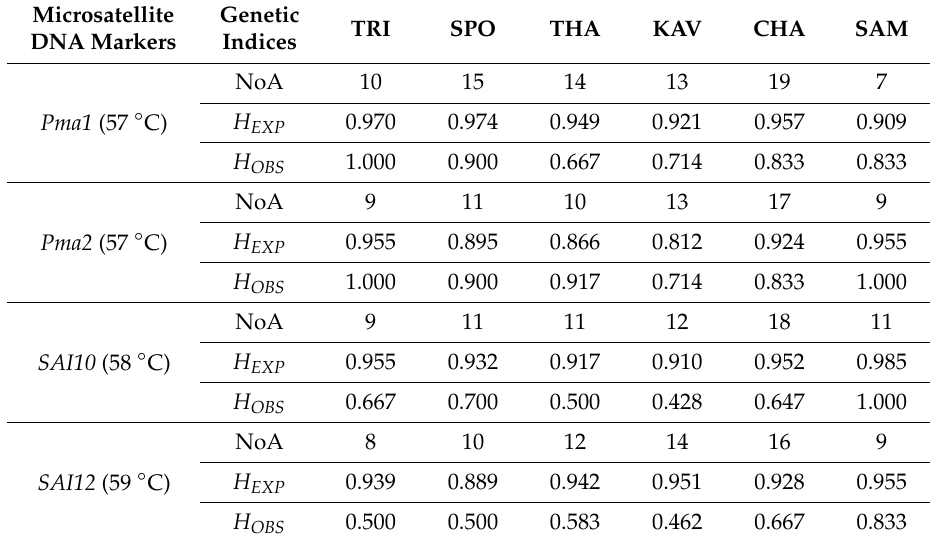
Figure 2. Cross-entropy plot for the number of cluster K = 1–8. The retained value of K is K = 2. Table 1. The panel of the four microsatellite DNA markers with annealing temperature in parentheses.